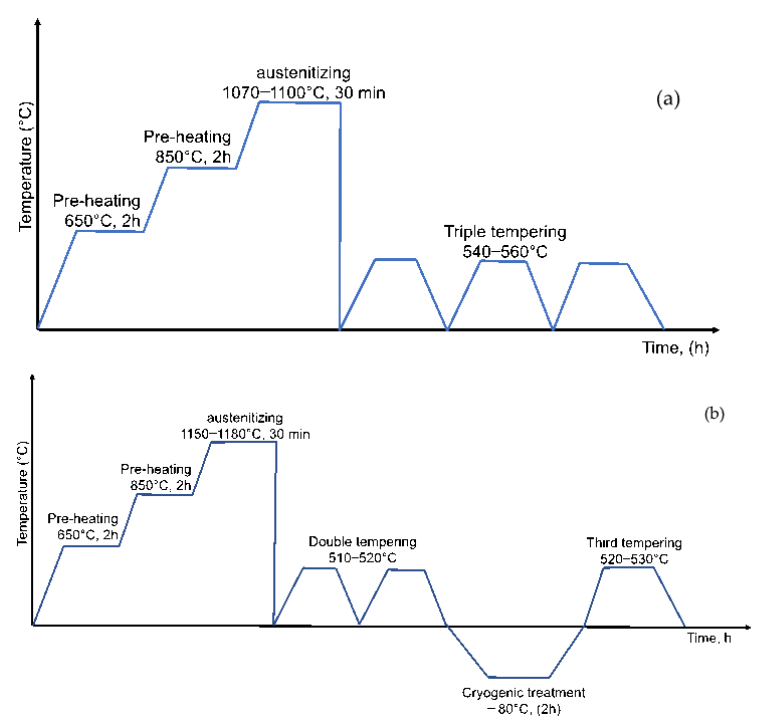
Figure 1. Schematization of K890-I ( a ) and K890-II ( b ) heat treatments .